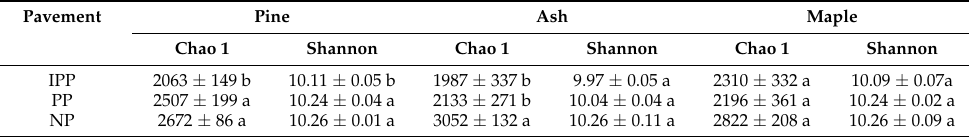
Table 1. Bacterial diversity and richness indices calculated from 16S rRNA gene sequence data at OTU level. Different letters indicate a significant difference among pavements at p < 0.05 based on Tukey’s HSD t est.